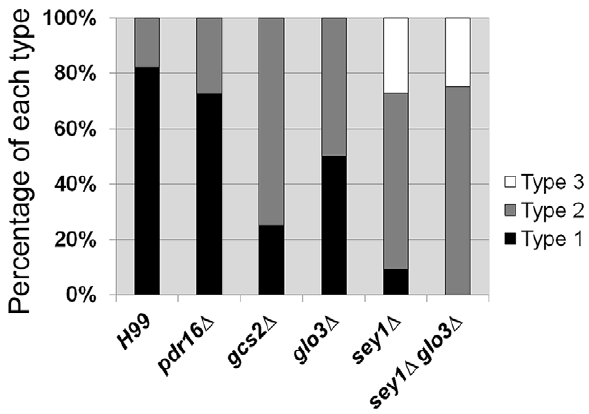
Figure 3. Frequency of Chr4 disomy formation in deletants of Chr4 genes. Clones resistant to 3LHF derived from each deletant were isolated and the copy number of Chr1 and Chr4 in the genome was inferred by assessing the copy number of the genes specific to each chromosome by qPCR. The figure displays the percentage of each type of disomy in the FLC resistant strains. Type1 denotes strains that contain Chr1 and Chr4 disomy, Type2 denotes strains that contain Chr1 disomy, Type3 denotes strains that contain no disomic Chr1 or Chr4.